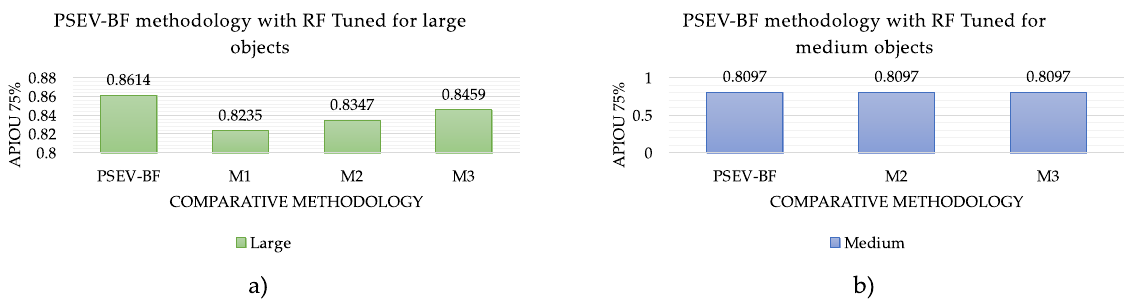
Figure 11. Results of the comparison of methodologies with different configurations based on the APIoU 75 metric using ( a ) large objects and ( b ) medium objects.